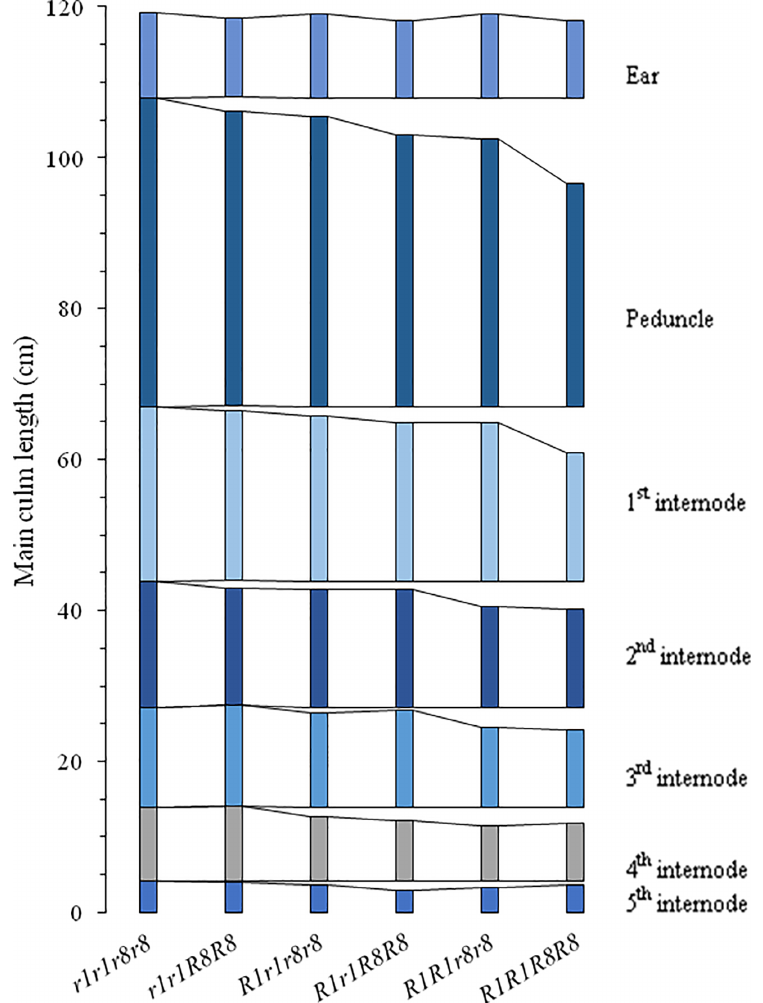
Fig 4. Diagrammatic representation of internodal elongation pattern in different gene